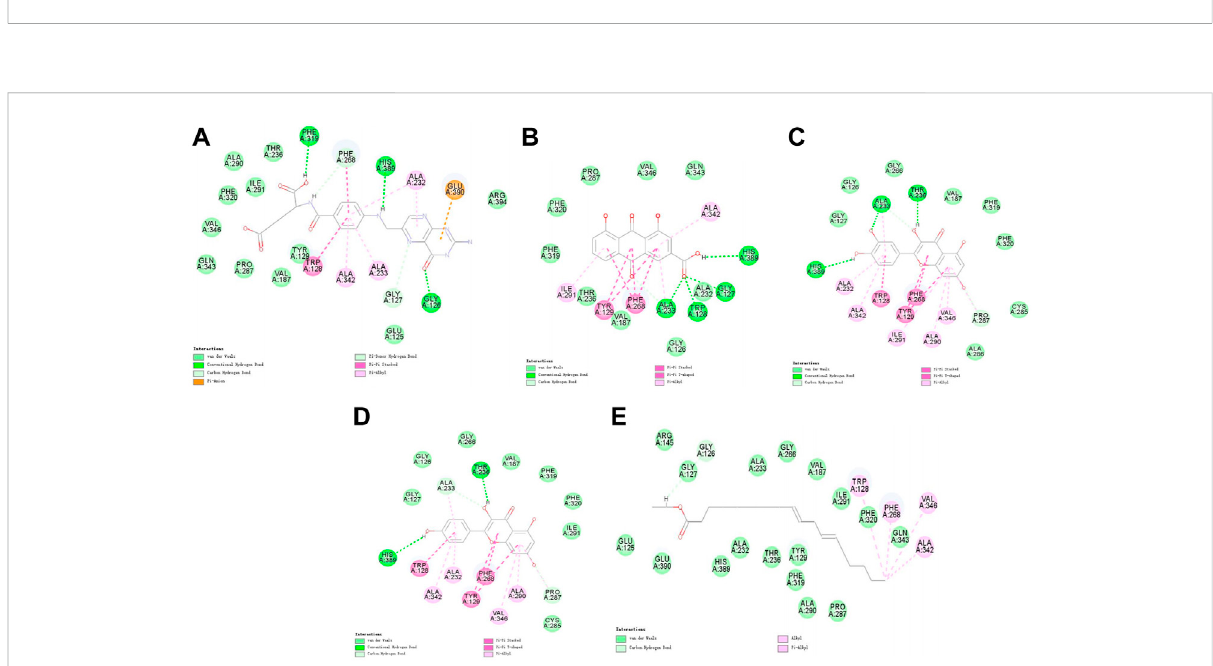
FIGURE 5 2D interaction map of Notum with selected small-molecule compounds. (A) Folic acid; (B) rhein; (C) quercetin; (D) kaempferol; (E)